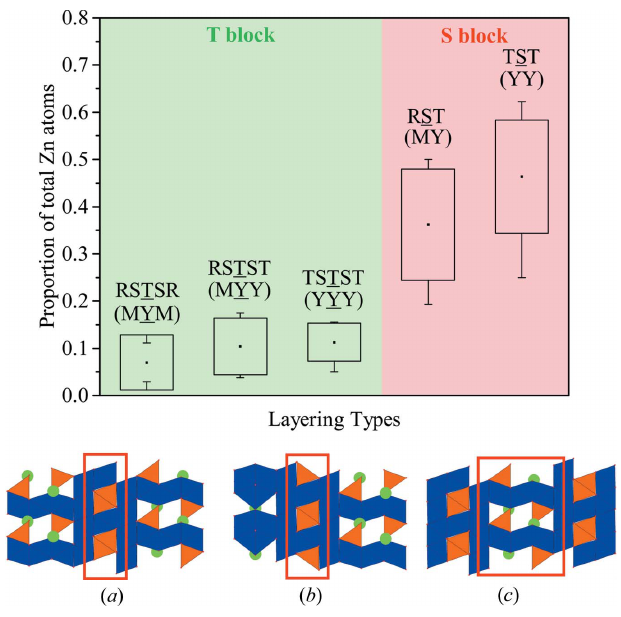
Figure 11 For each hexaferrite, we have determined the number of zinc atoms located in the layer types: RSTSR, RSTST, TSTST, RST and TST. We have plotted the fraction of the total number of zinc atoms in each hexaferrite that is located in that given layer, and averaged over all nine of the mixed-layer structures that we have characterized. The boxes denote one standard deviation, with the whiskers at the minimum and maximum of each range. The ( a ) TST, ( b ) RSTand ( c ) STS layering types are shown considering their first neighbours.